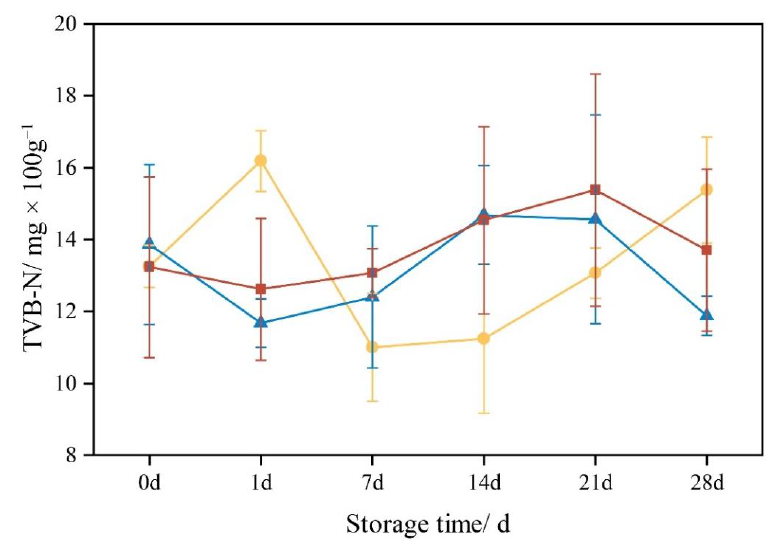
Figure 5. Variation trend of TVB-N value during storage of lamb liver paste. Note: yellow represents the natural fermentation group (NF); blue represents the starter fermentation group (SF); red represents the sterilization group (ST).